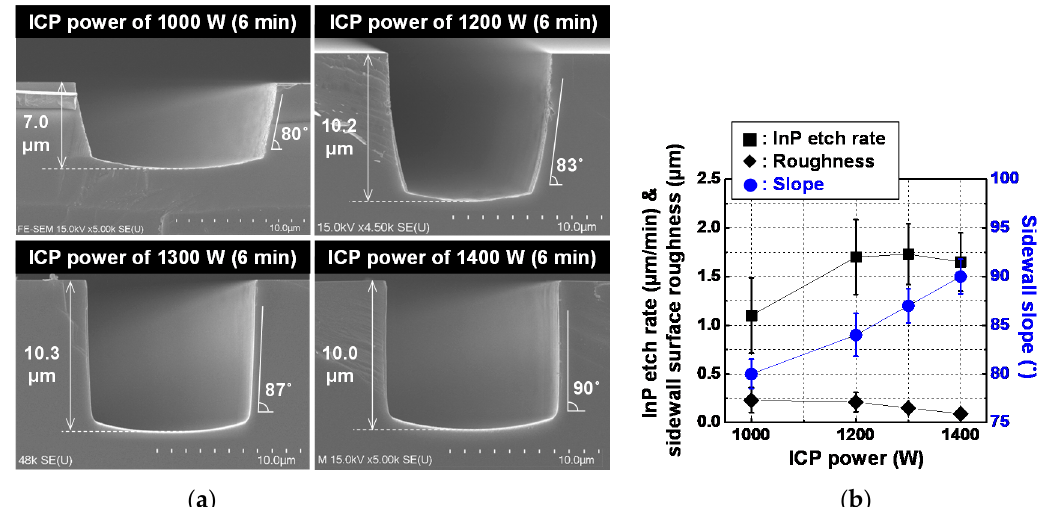
Figure 6. Fabrication results of InP via holes etched at different levels of ICP power: ( a ) SEM images of representative etch profiles and ( b ) InP etch rate, sidewall surface roughness, and sidewall slope of fabricated InP via holes. Error bars in Figure 6b represent the deviation values for a total of 60 InP via holes with the identical layout pattern in the three fabrication lots. RF power, Cl 2 /Ar gas mixture, operation pressure and operation temperature of the ICP etcher were 294 W, 20/15 sccm, 5 mT and room temperature, respectively.